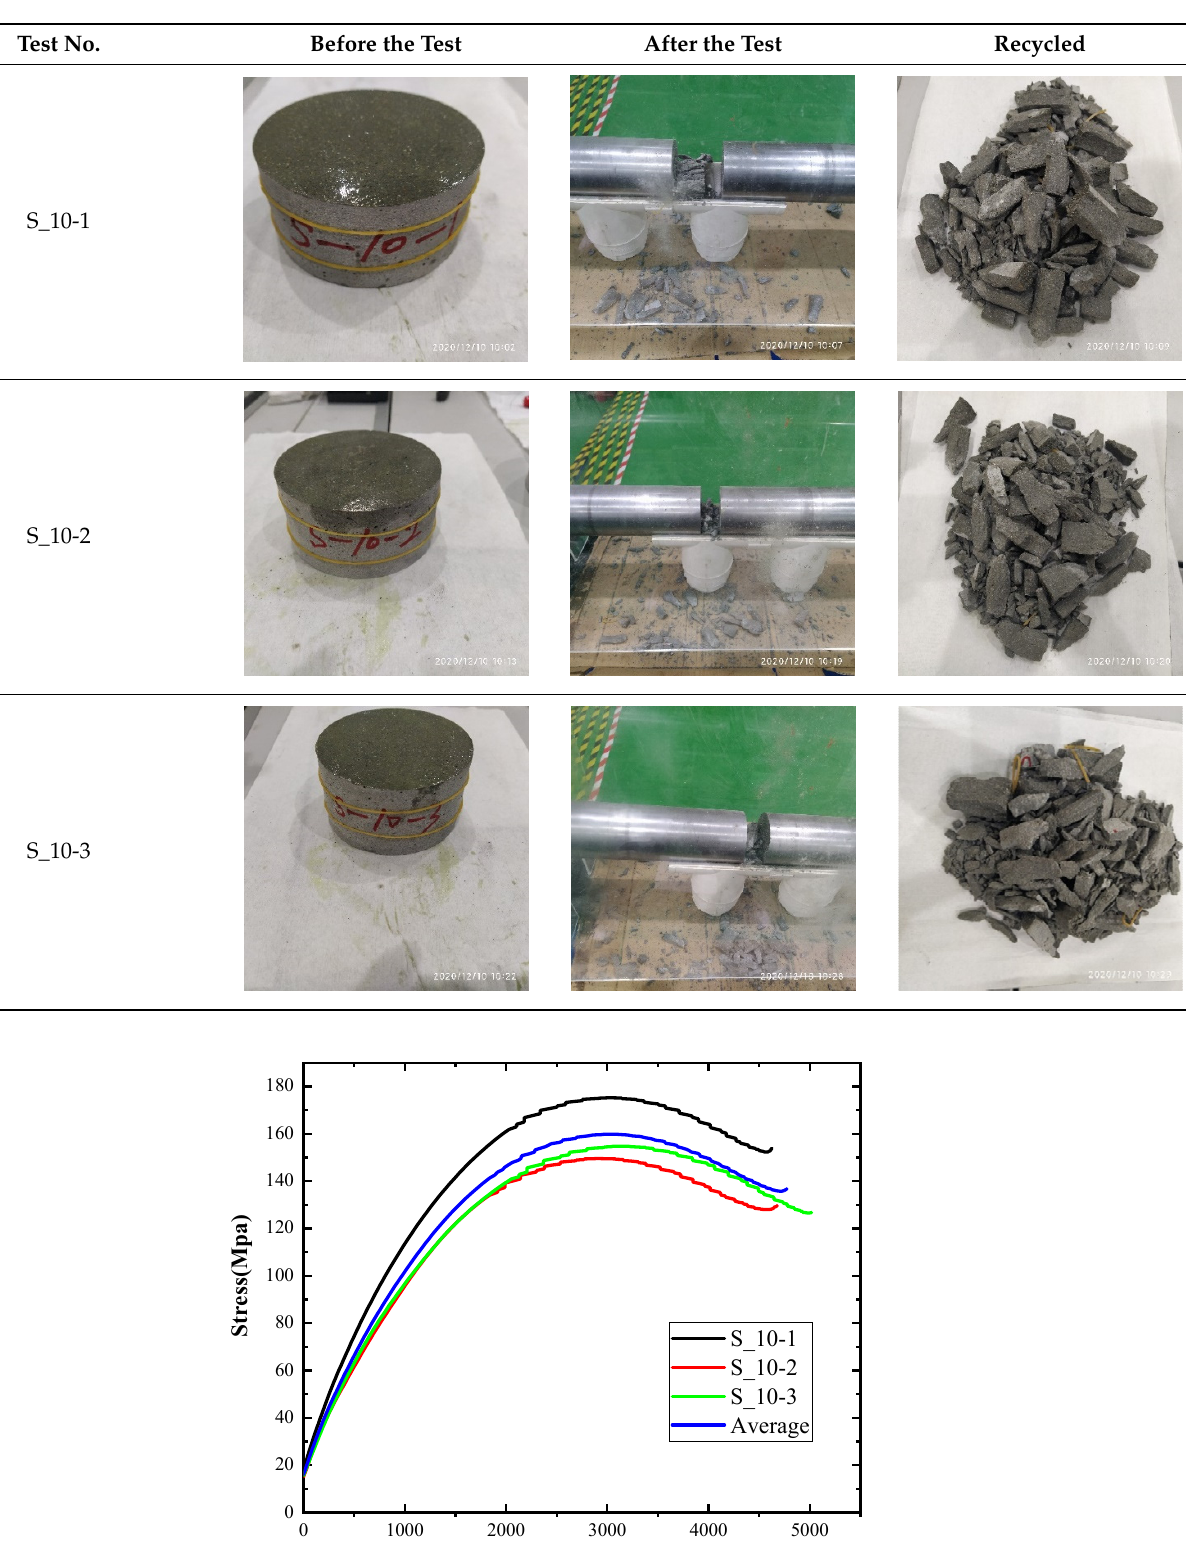
Table 4. Test results at an impact velocity of 10 m/s.